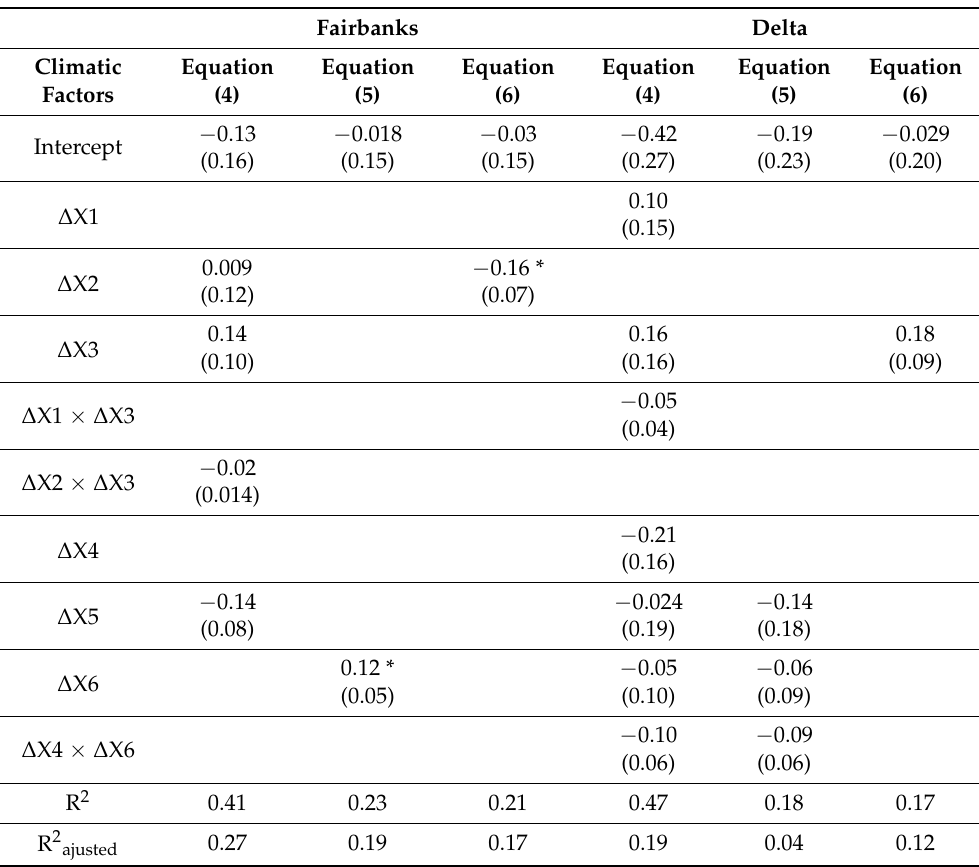
Table 5. The coefficients, R 2 , and R 2 ajusted of best models for cultivar ‘Thual’ selected from Equations (4)–(6). The climatic factors are ∆ X1– ∆ X6 which represent ∆ TminBH, ∆ TdtrBH, ∆ PBH, ∆ TminAH, ∆ TdtrAH, and ∆ PAH at 10 days BH and AH,